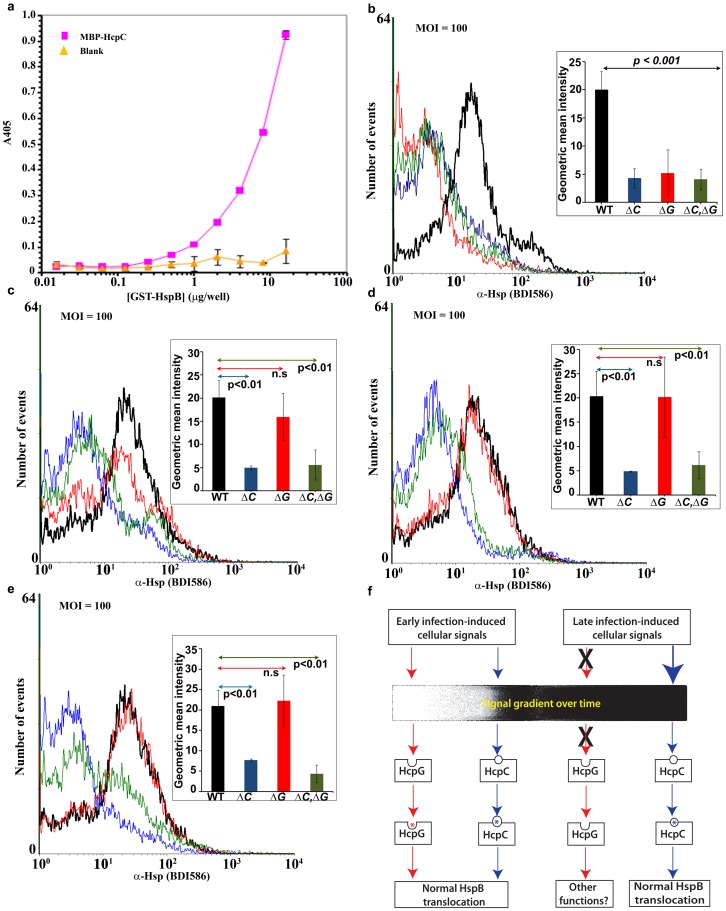
Modulation of HspB translocation by HcpG and HcpC during H. pylori infection.(a) ELISA performed to determine the specificity of HcpC-HspB interaction, in vitro. (b–e) FACS analyses of HspB translocation in single- and double hcp gene mutants and in the parent HpG27MA WT strain (b) 3, (c) 6, (d) 12, and (e) 24 h after infection of serum-starved confluent AGS cell cultures. Overlapping histograms of mean geometric intensity from individual infections were generated using the WINMDI software program (version 2.9; Joseph Trotter, Scripps Research Institute, LA Jolla, CA). x-axis, α-HspB fluorescence; y-axis, number of events measured for each sample (104 cells/sample). A shift of fluorescence to the left indicates reduced intensity. The FACS parameters are listed in supplementary methods available in File S1. Inset, bar graphs showing the geometric mean intensity of α-HspB fluorescence at each time point after infection with mutant and WT strains, respectively. The strains are color-coded as follows: Black, WT; blue, ΔhcpC; red, ΔhcpG; and green, ΔhcpG,ΔhcpC. The results show the averages from three experiments (± SD). (f). Model of observed functional interactions of HcpC, HcpG, and HspB translocation depending on the temporal context of the infection.